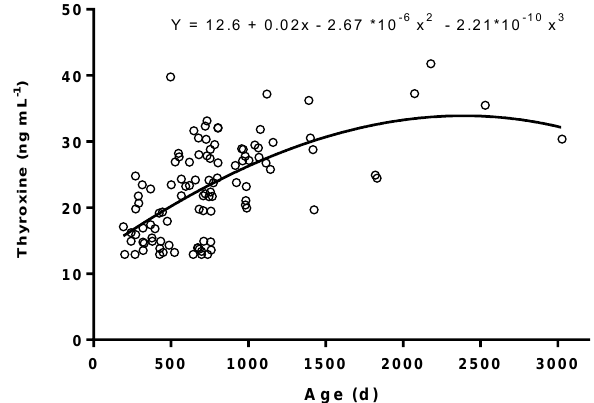
Figure 3. Age-related variations in plasma testosterone concentra- tions in male Murrah buffaloes ( n =